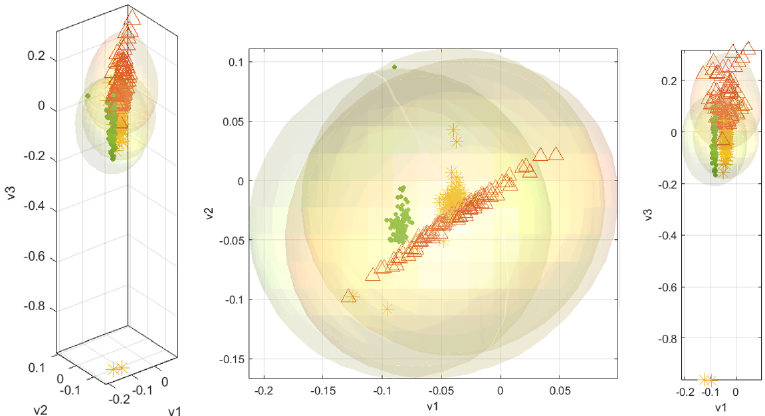
Figure 13. Representation of person asking for help (police) in green points, traffic accidents (health services) with brown triangles, and crashes (transit) with yellow stars. The three categories or emergencies plotted appear close one to another in both 3D and 2D plots. This distribution of emergencies and the overlapped elliptical shapes lead us to infer that these categories or emergencies types are significantly related.